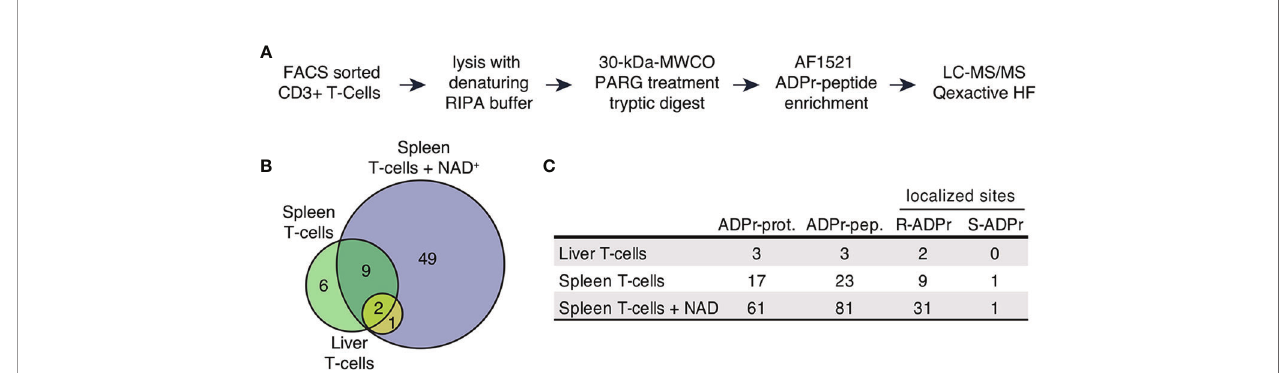
FIGURE 1 | The ADP-ribosylated proteome identi fi ed in T cells. (A) Schematic work fl ow of proteomic sample processing, digestion and ADPr-peptide enrichment tailored to the low input protein amount obtained from FACS sorted T cells. (B) ADP-ribosylated proteins identi fi ed in the three different sample types depicted in a Venn diagram. (C) Numbers of uniquely identi fi ed ADP-ribosylated proteins, unique ADP-ribosylated peptides and modi fi ed amino acids that were con fi dently localized (localization probability > 70%). Modi fi ed arginine and serine sites were